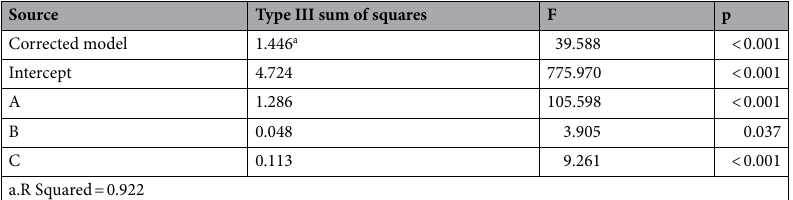
Table 4. Analysis of between-sample effects. Dependent variable = concentration. A represents the storage time of fresh whole blood at room temperature; B represents the storage time of RNA at room temperature; C represents the storage time of cDNA at − 20 °C.